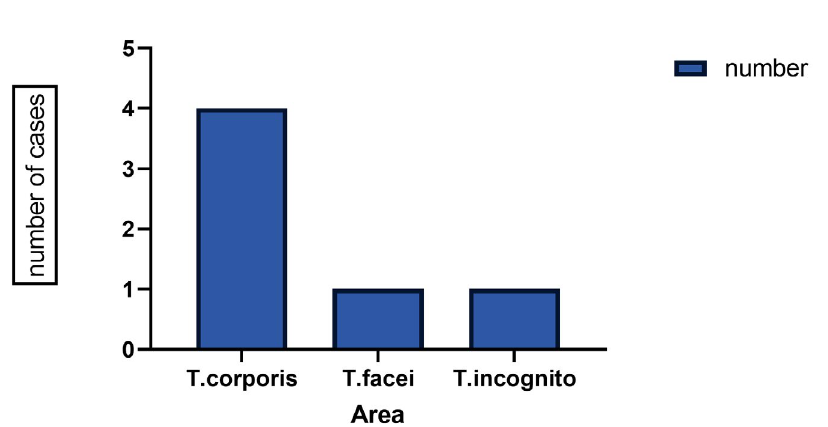
Fig. 3. Distribution of samples